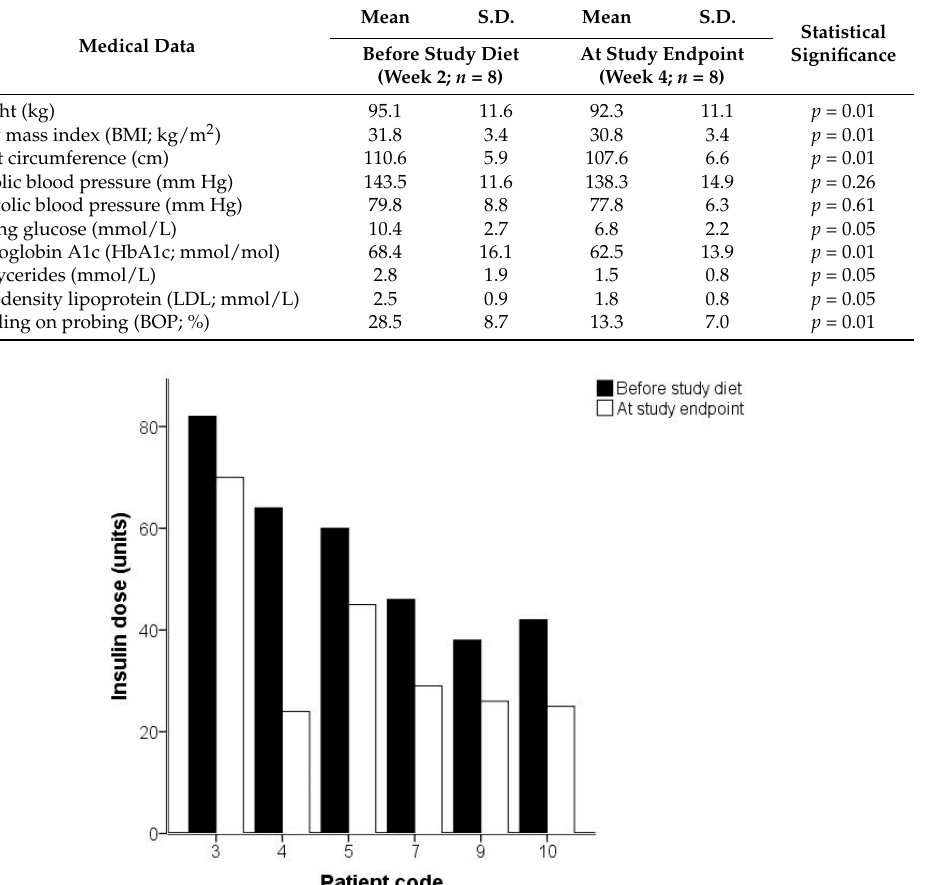
Figure 1. Bar chart diagram illustrating changes in insulin dose for the individuals reducing their insulin treatment after two weeks with the Okinawan-based Nordic diet.